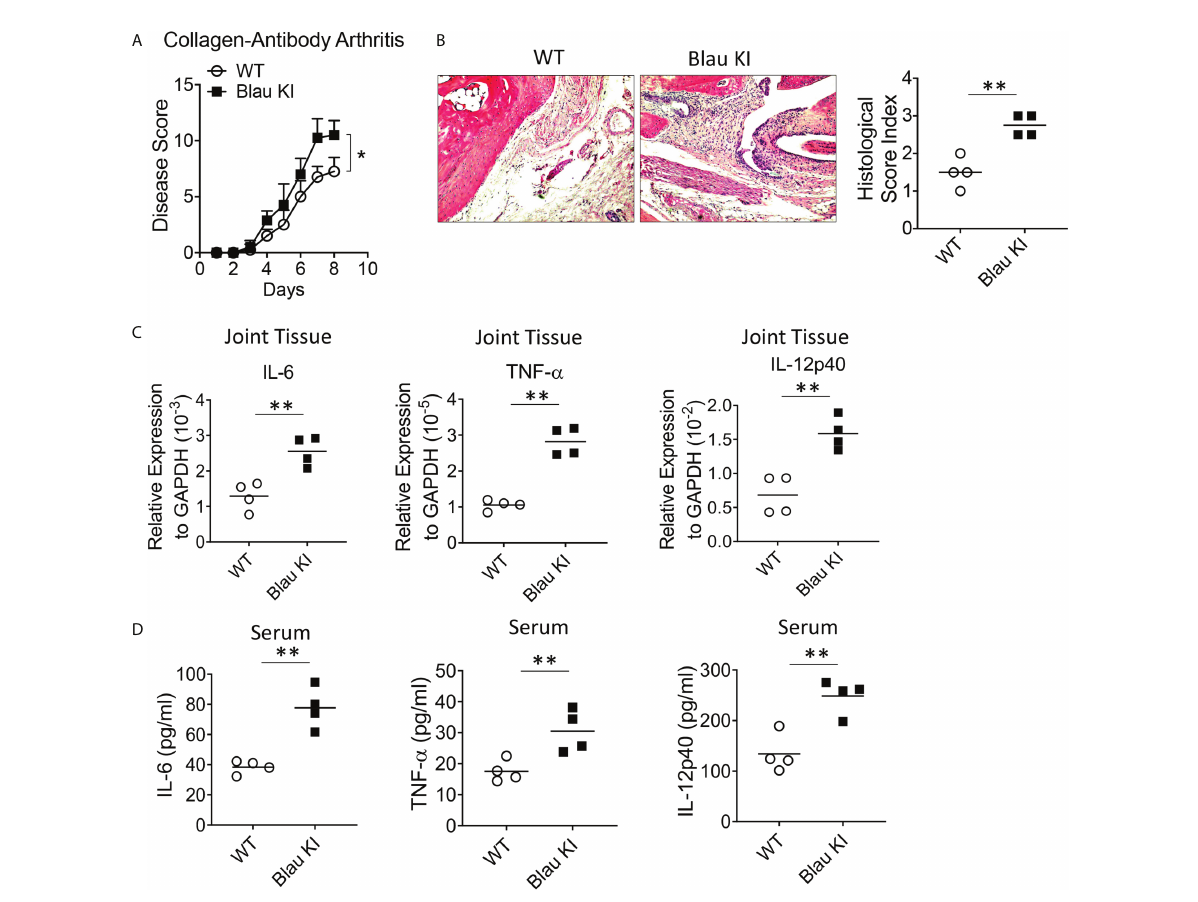
FIGURE 8 The BS-NOD2 Mutation Causes Loss of NOD2 Cross-Regulation of TLR Responses in vivo . (A, B) Blau KI mice (homozygous, n=4) and their wildtype littermates (n=4) were administered anti-collagen antibody cocktails (5mg/mouse I.P.) on day 0; the mice were then administered LPS (50ug/mouse, I.P.) on day 3 and were euthanized on day 7. (B) Representative histology of joints after H&E staining of tissues from both mice; disease severity was evaluated by arthritis score. (C) Joint tissues were harvested for RNA extraction, which were then subjected to reverse transcription and real time RT-PCR for transcription of pro-in fl ammatory cytokines, IL-6, IL-12p40 and TNF-?. (D) Serum samples were collected from mice and concentration of IL-6, IL-12p40 and TNF-? was examined by ELISA. Data were analyzed using a two-way ANOVA with Tukey ’ s multiple comparisons; *p<0.05;